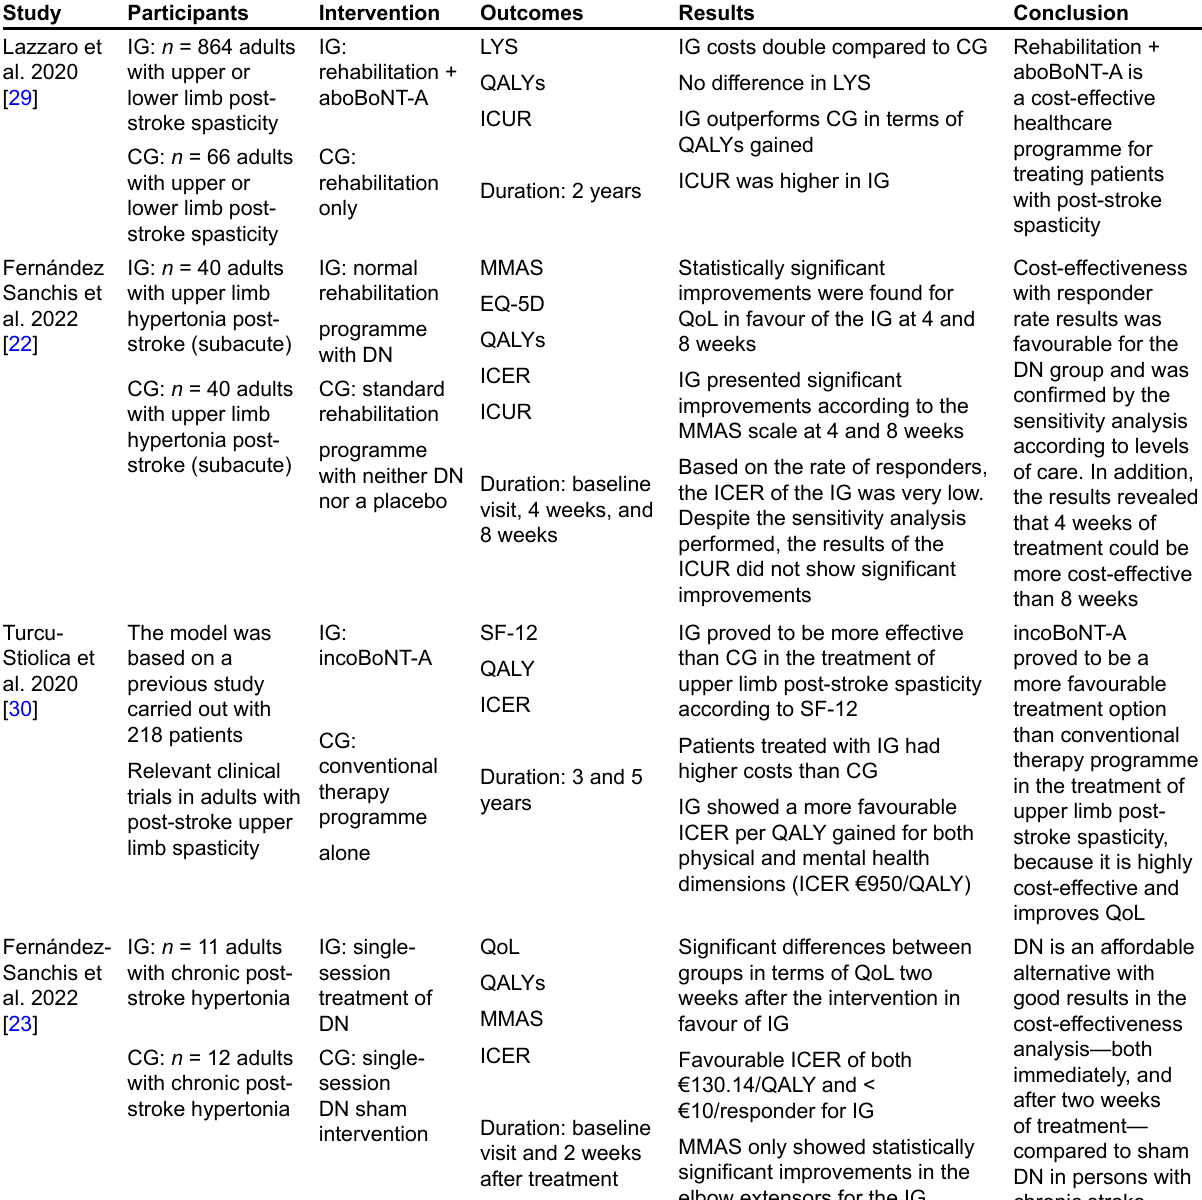
Table 1. Study characteristics of the included trials ( continued )